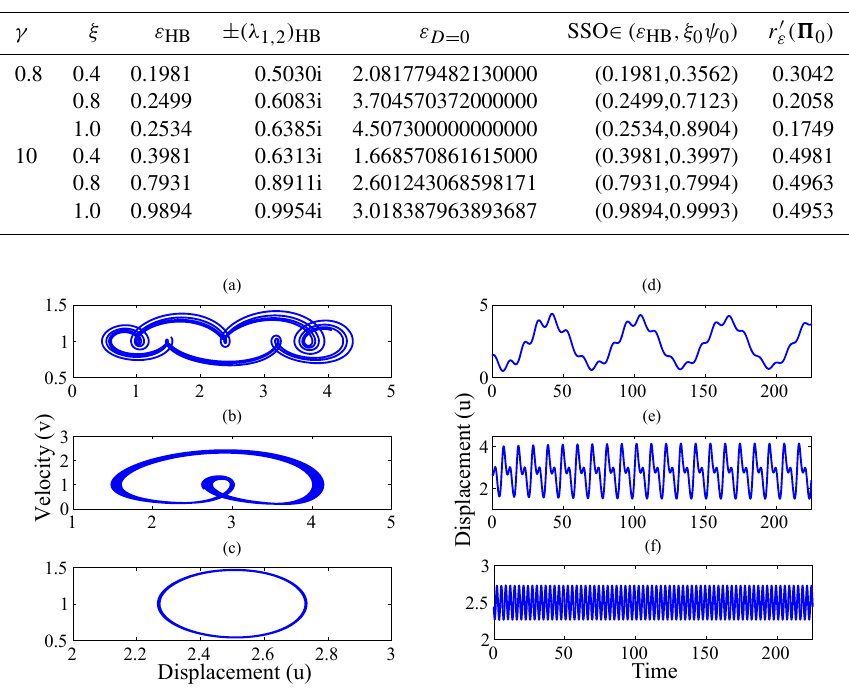
Table 1. Relationship between parameters (cid:53) on the oscillatory range for Fig. 4a and b ε HB is the value of the Hopf bifurcation; ( ± λ 1 , 2 ) HB is the eigenvalues on the imaginary axis; ε D = 0 is the value when the discriminant of the characteristic polynomial is equal to zero, i.e., the upper limit of OR; SSO is the interval of self-sustained oscillations; and r (cid:48) ( (cid:53) 0 ) is the cross-velocity of eigenvalues. γ ξ ε HB ± (λ 1 , 2 ) HB